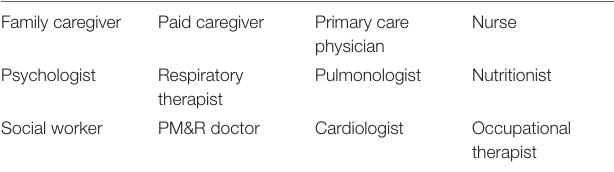
TABLE 3 | Selection of care team